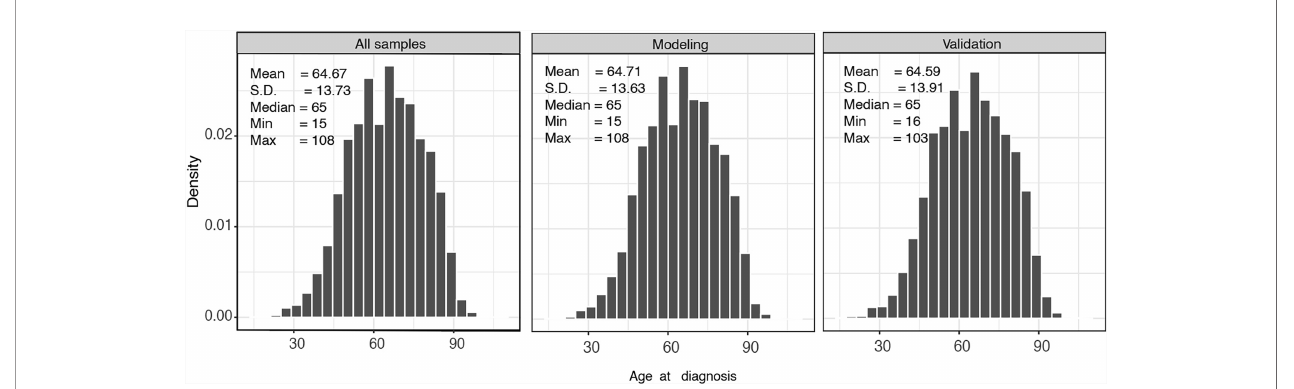
FIGURE 2 | Histogram of the age distribution of all samples, modeling set, and